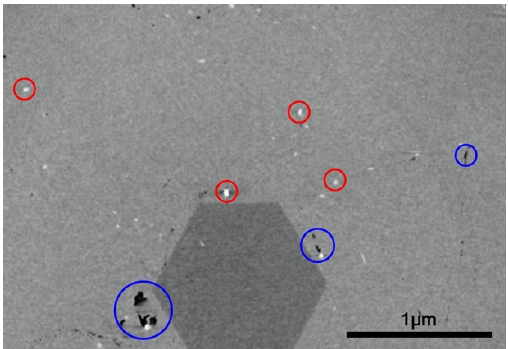
Figure 5. The HRXCT image shows the metal minerals (red circle) and voids (blue circle) in the sample, accompanied by a hexagonal core. sample, accompanied by a hexagonal